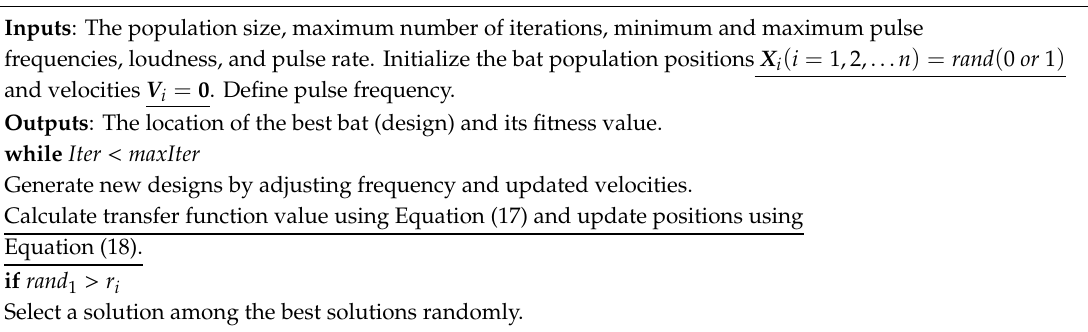
Algorithm 2 . Pseudocode of BBA